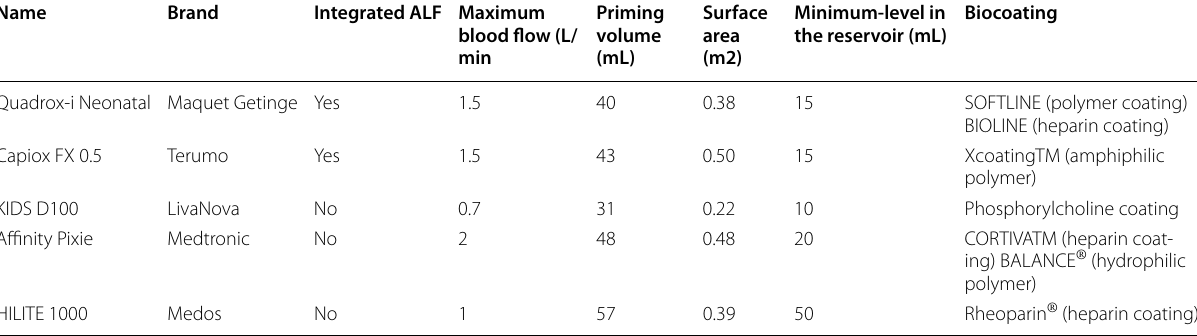
Proper permission has been taken to reproduce this table from original author